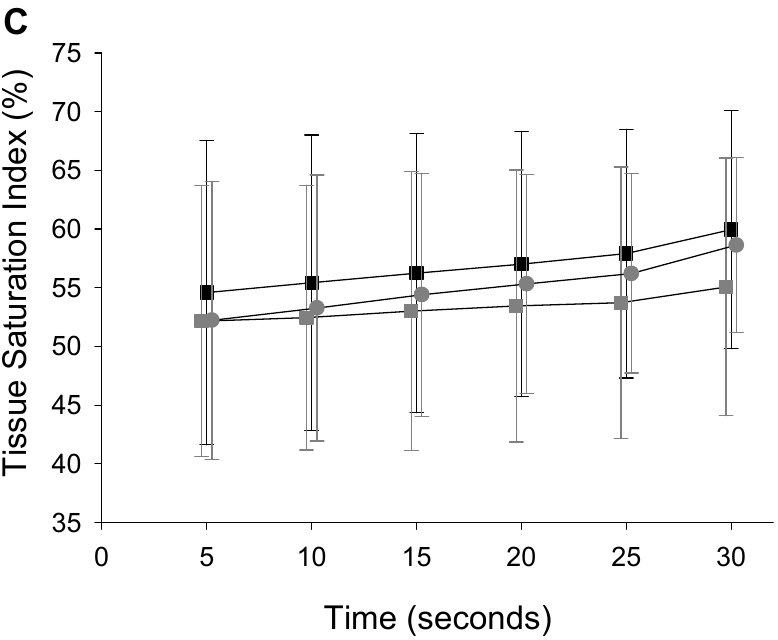
Figure 7. Five second averages of oxygenated hemoglobin ( A ), total hemoglobin ( B ) and TSI ( C ) during the 30 s maximal Wingate test. Comparing across the three conditions, there were no differences during the first 5 s, final 5 s, the delta from the first to last 5 s or the average across the entire 30 s test. DLN = Double-Leg Normoxia; DLH = Double-Leg Hypoxia; SLH = Sigle-Leg Hypoxia. Table 1. Mean difference, 90% CI and effect size for significant comparisons.